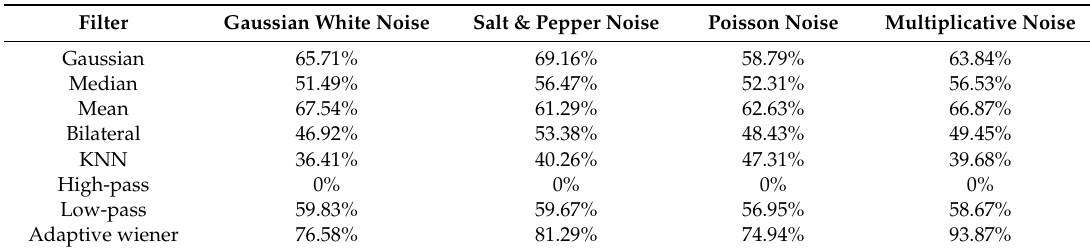
Table 2. The performance of di ff erent combination of noise addition and filtering on adversarial examples (correct classification rate).